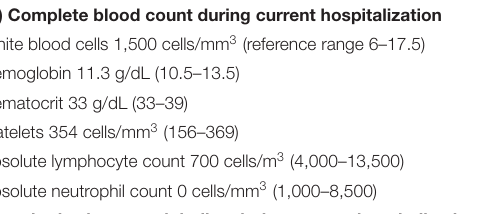
TABLE 1 | Abnormal immunologic